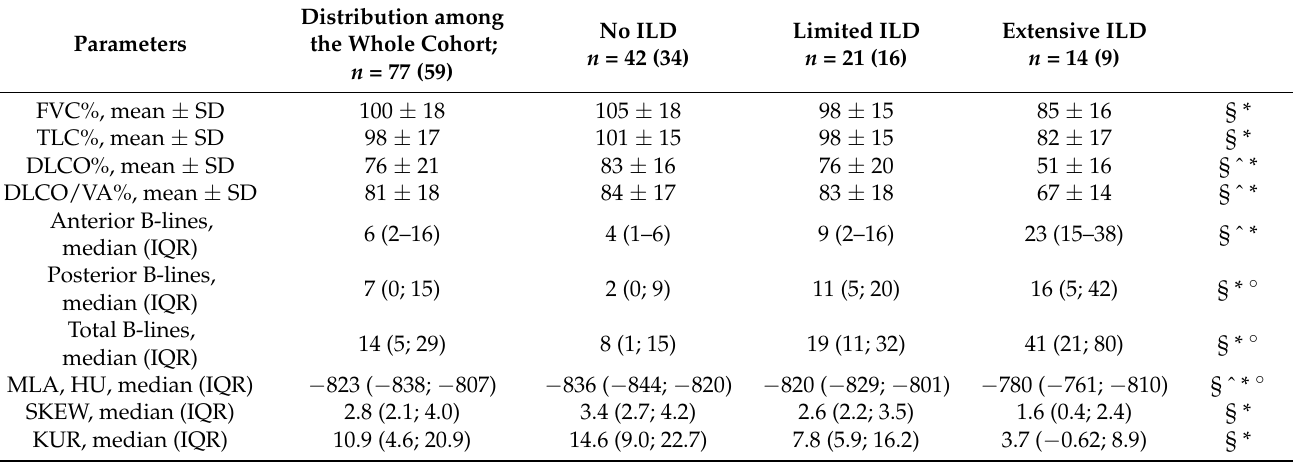
Table 2. Distribution of pulmonary functional parameters, B-lines and radiomic parameters among the study population and stratified according to lung involvement. Patient numbers in brackets refer to the subgroup with available radiomic